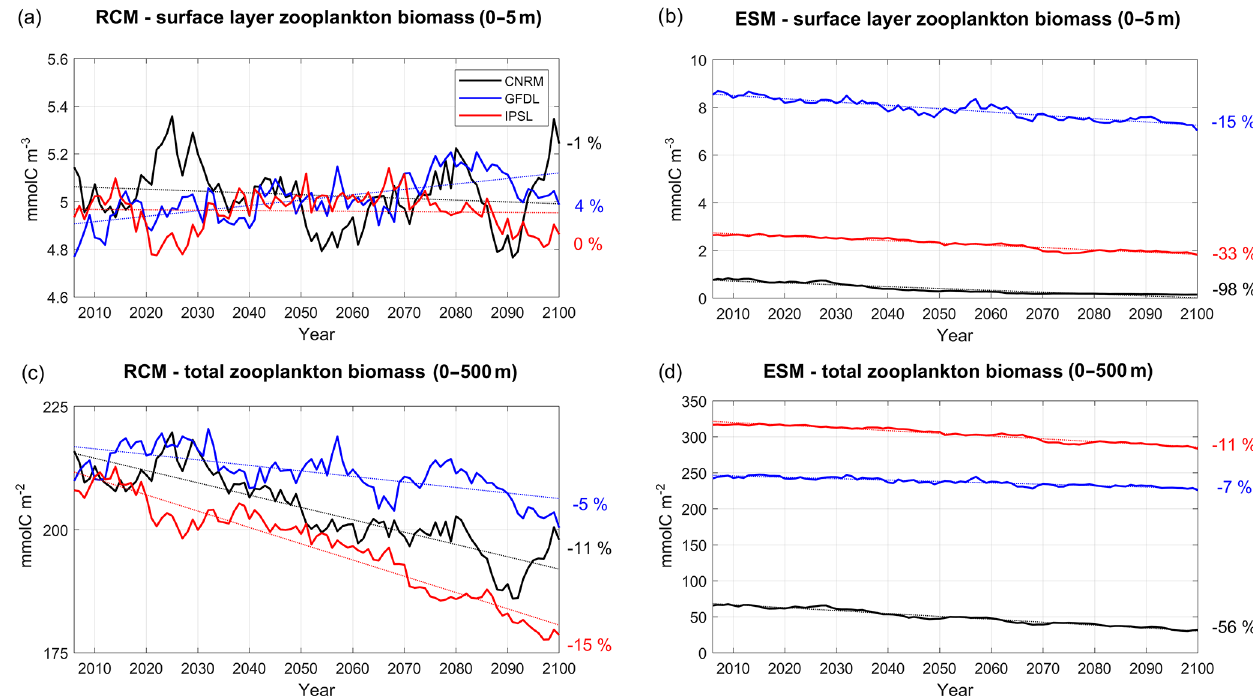
Figure 15. Same as 12 but for zooplankton (mmolCm − 3 ) for the 0–5m surface layer in (a) and (b) and for the depth-integrated values (mmolCm − 2 ) in (c) and (d) .